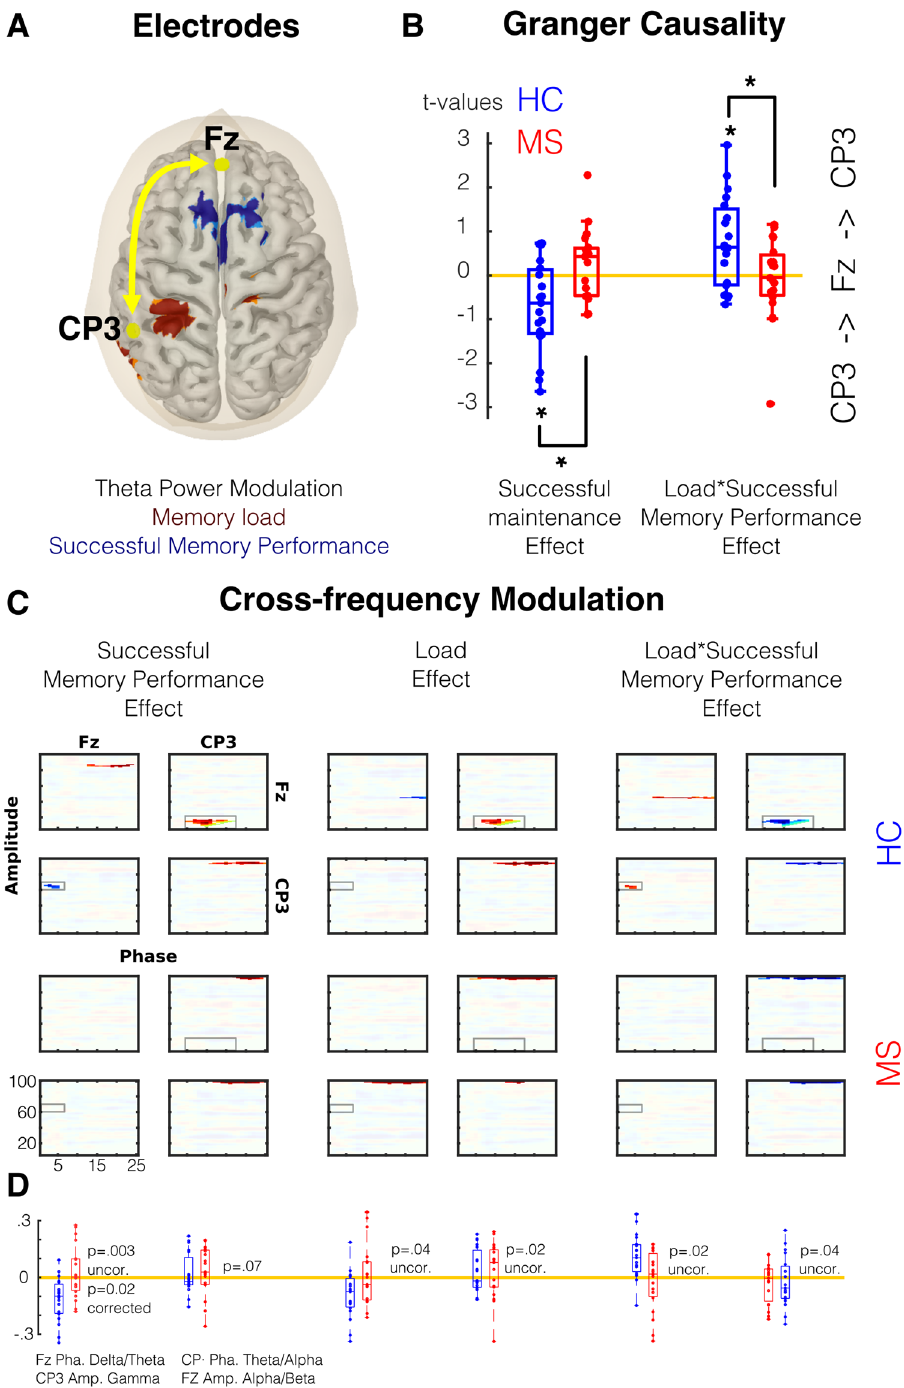
Figure 6. Connectivity Analysis. ( A ) Selected electrode and the source of the theta modulation as showed in Fig. 5. ( B ) the t values resulting of single trial models of the Granger Causality between Fz and CP3 electrodes during maintenance (See also Table 2). ( C ) Cross-frequency modulation using PAC analysis. Significant areas are highlighted (CBP test p < 0.05). ( D ) Comparison between groups in areas where healthy control showed significant modulation. Red depicts Multiple Sclerosis (MS) group and blue Healthy Control (HC)